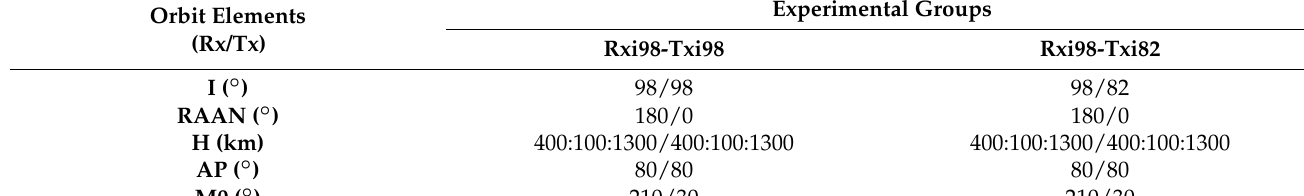
Table 2. The main orbital elements of the transmitting and receiving satellites for the near-polar orbit (NPO) constellations. The chosen set of values for some elements is denoted in the format of StartValue:Step:EndValue; simulations were performed using an ensemble of configurations stepping through all value settings for these elements.